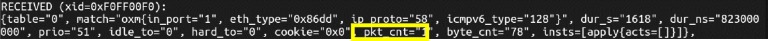
Snapshot of the switch showing that Flow-Entry-1 matches one packet.